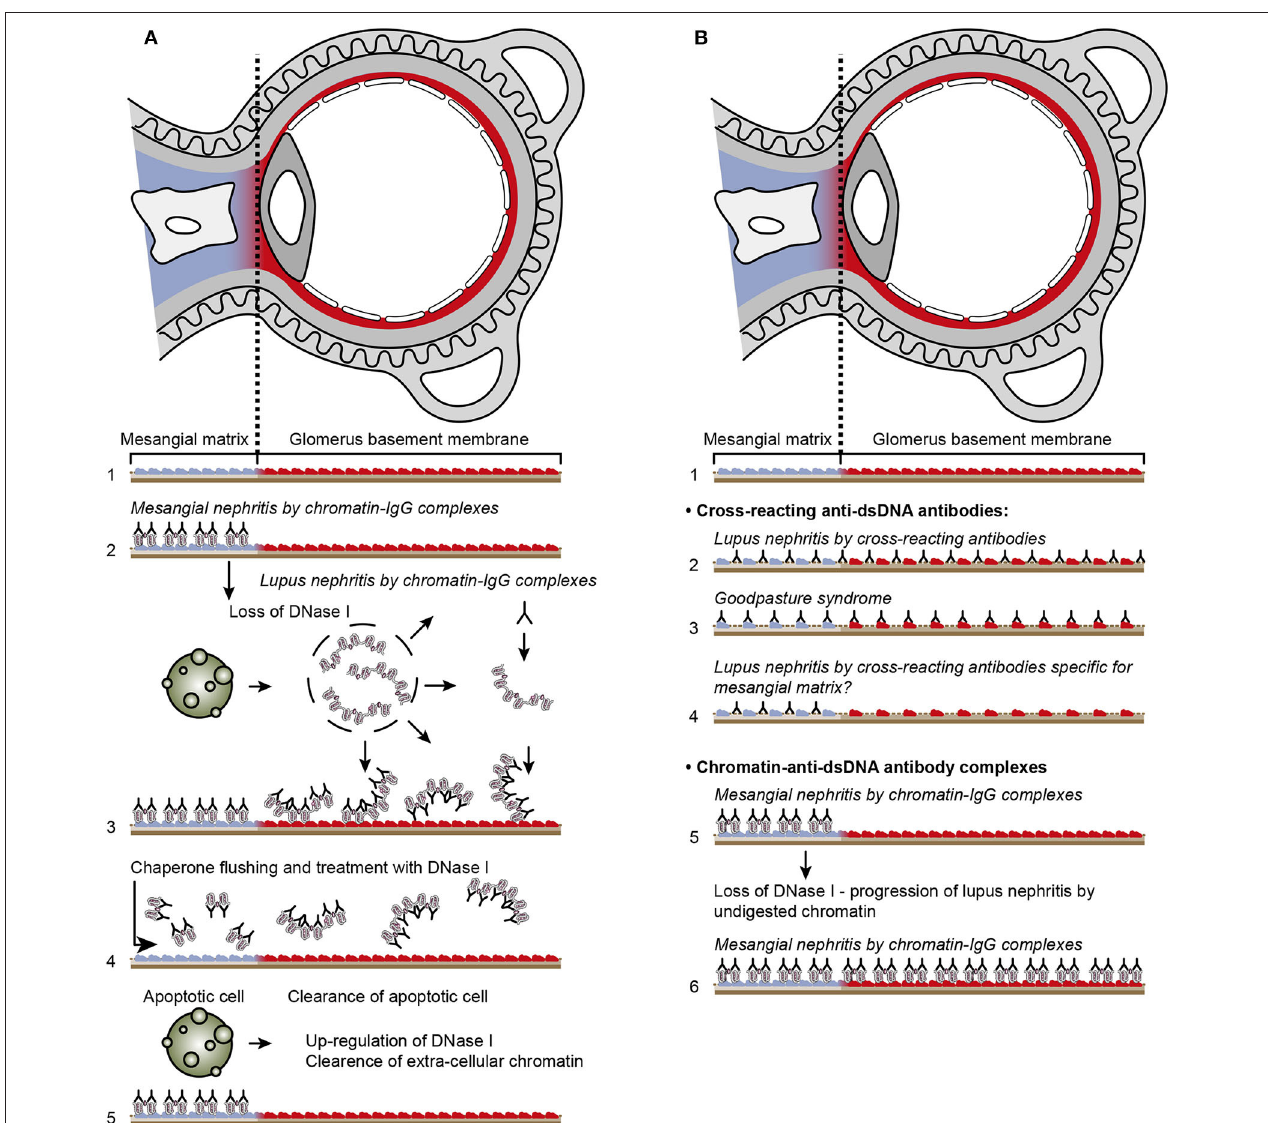
FIGURE 4 | Principal problems to be solved before the chromatin or the cross-reactive model for lupus nephritis can be settled. In (A) , the chromatin model is presented. On top, a principal presentation of the architecture of a glomerulus is described. In line 1, the mesangial matrix (blue) and its transition into the GBM (red) is principally demonstrated. In a classical progression of lupus nephritis (177, 178), chromatin-IgG complexes deposit in the mesangial matrix and form the early mesangial nephritis (line 2). One consequence of this limited inflammation is silencing of the renal endonuclease DNase 1, a consequent reduced fragmentation of chromatin from dead cells, and a subsequent deposition of large chromatin fragments in complex with IgG within the GBM [line 3, (178, 179)]. This forms the process that promote glomerular inflammation and progression of lupus nephritis into end stage disease [discussed in (11)]. Silencing of DNase 1 expression in this situation is unique to the kidney and does not occur in other organs (179). Since chromatin-IgG complexes bind laminins and collagens in the GBM with relatively high affinity (180), and are released locally in the glomerulus, these observations may explain the canonical progression of lupus nephritis as described by Weening et al. (177). This process may have therapeutic consequences, since chromatin prone to be deposited in GBM may be removed by flushing kidneys with the negatively charged heparin or other analogous chaperone molecules [line 4, (181) 5 ], and theoretically, the process may be interrupted upon upregulation of renal DNase 1 expression [line 5, (181)]. In (B) , the glomerulus architecture is organized as in (A) , and the matrix-GBM transition is principally illustrated (line 1). In the cross-reacting model, cross-reacting anti-dsDNA antibodies bind intrinsic glomerular structures like entactin, laminin or collagen (line 2, see also data in Table 2 ). Since these antibodies may bind ligands shared by mesangial matrix and GBM, the antibodies are expected to bind simultaneously in the mesangial matrix and in the GBM (line 2). Therefore, the cross-reactive antibodies might well-initiate a glomerular inflammation more similar to the renal inflammation in Goodpasture syndrome (line 3) than to the stepwise progression of lupus nephritis as illustrated in (A) , lines 2 and 3. This consequence has not been considered in the relevant literature. One possible exception for this Goodpasture-like inflammation would be an early production of antibodies specific for a ligand unique for the matrix (suggested in line 4) and that the